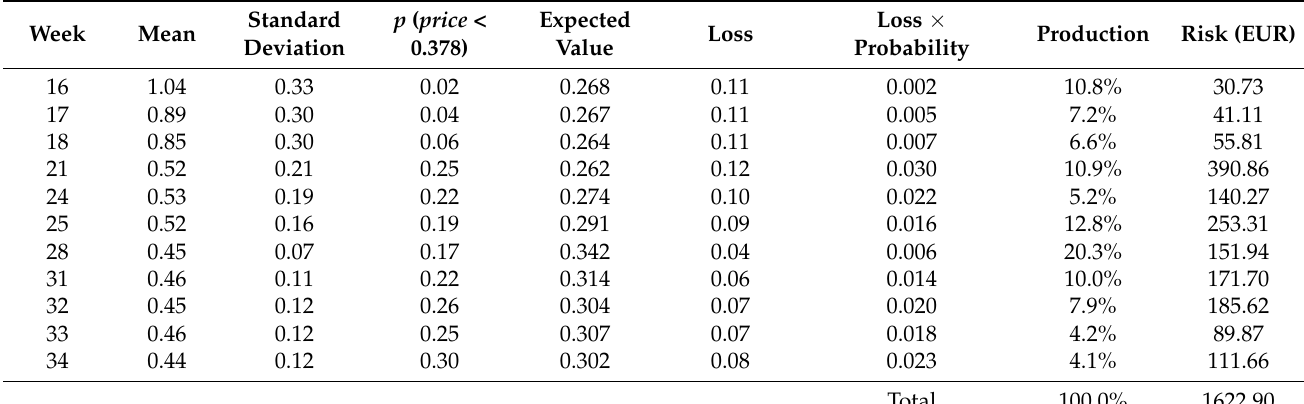
Table 3. Obtaining weekly risk of pepper production as product of weekly production per estimated loss and its probability. Week